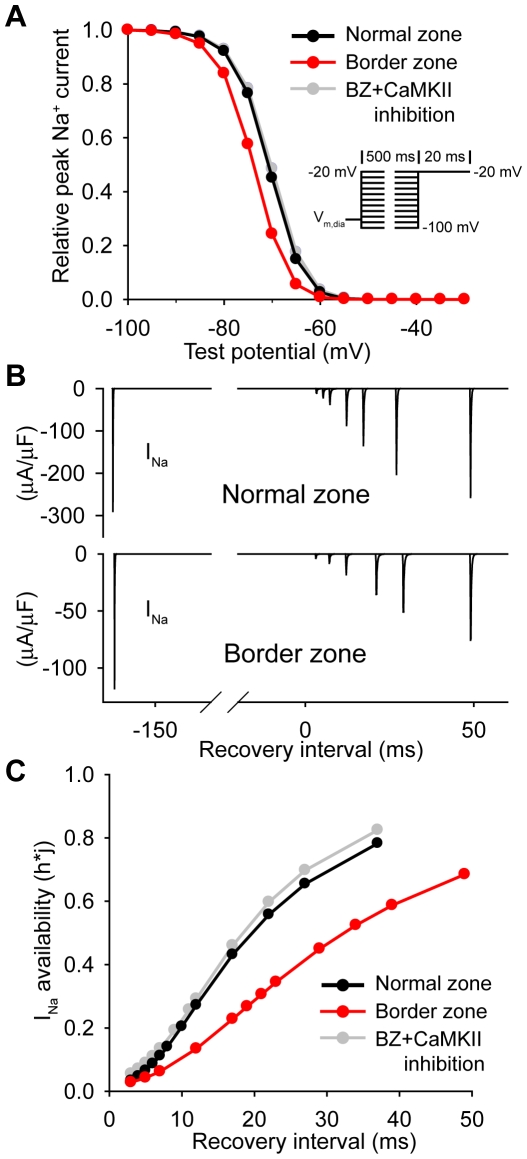
CaMKII regulates INa in the infarct border zone.(A) Steady-state INa inactivation curves in NZ and BZ models (pulse protocol shown in inset). Inhibition of the CaMKII pathway (CaMKII activity held constant at zero) eliminates differences between NZ and BZ INa steady-state inactivation. (B) Simulated Na+ currents in control (top) and border zone (bottom) models during application of a premature stimulus to cell 1 at varying S1S2 interval to determine recovery from inactivation. (C) INa availability (h*j) in control and border zone models with and without CaMKII inhibition. INa recovery is dramatically slower in the border zone fiber compared to control. CaMKII inhibition in the BZ accelerates recovery from inactivation to a rate similar to NZ (recovery curve for NZ model + CaMKII inhibition superimposes curve for BZ model + CaMKII inhibition, not shown).